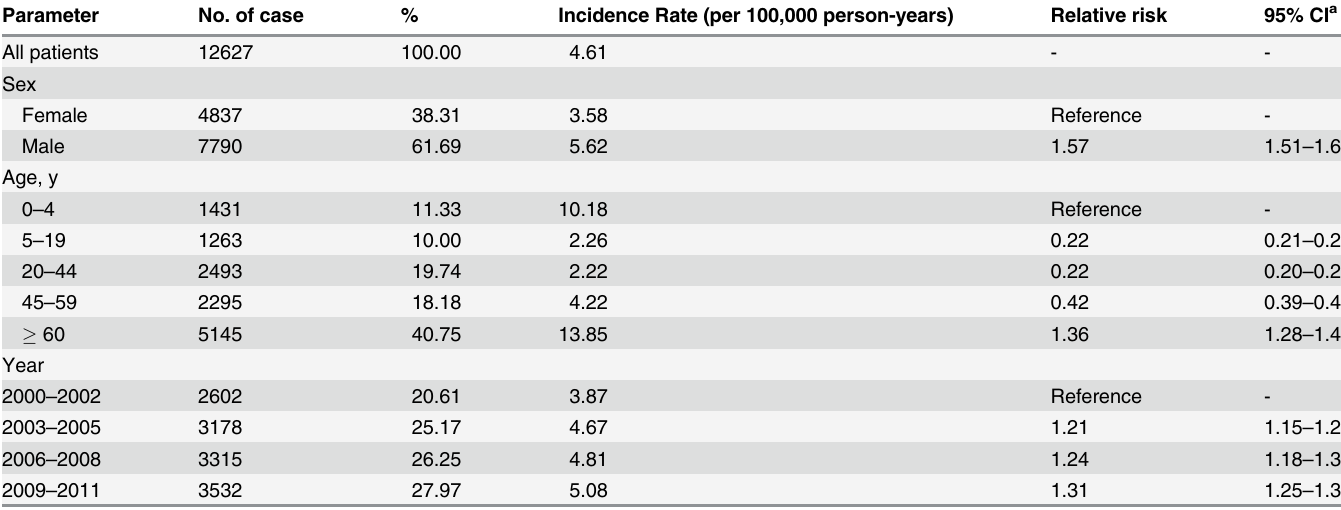
Table 1. Incidence of SE hospitalizations in Taiwan from 2000 –